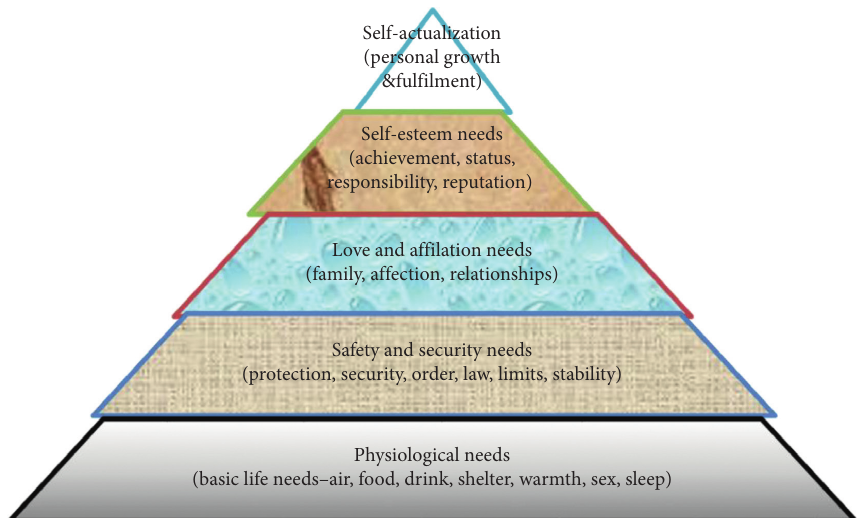
Figure 1: Maslow’s hierarchy of needs (five-stage model). Source: Rue and Byars